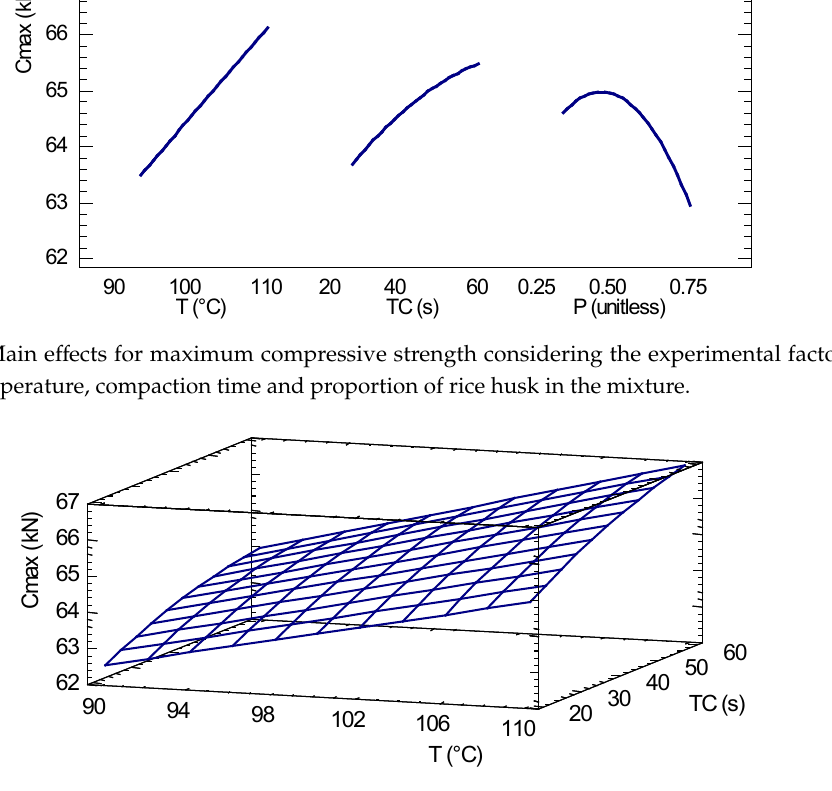
Table 10. Results for modulus of elasticity in rice husk and pine sawdust briquettes. Treatment